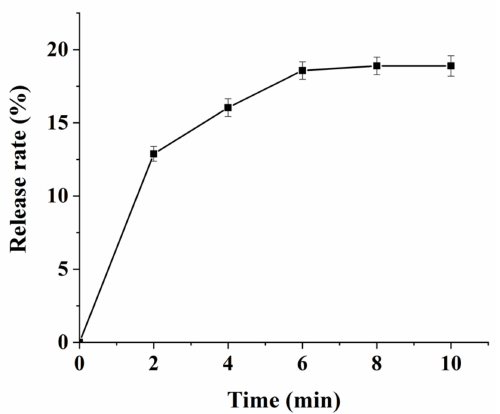
Figure 8. The Cu 2+ release curve of hydrogel loaded with CuS NPs under near-infrared light